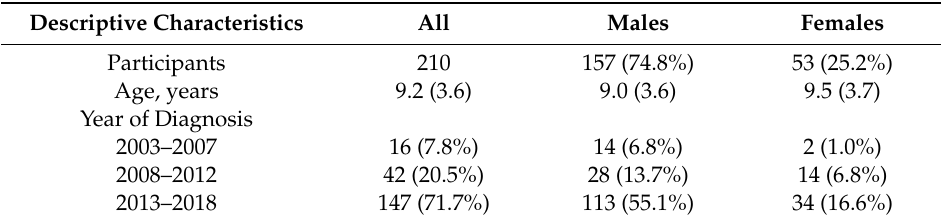
Table 1. Descriptive characteristics.